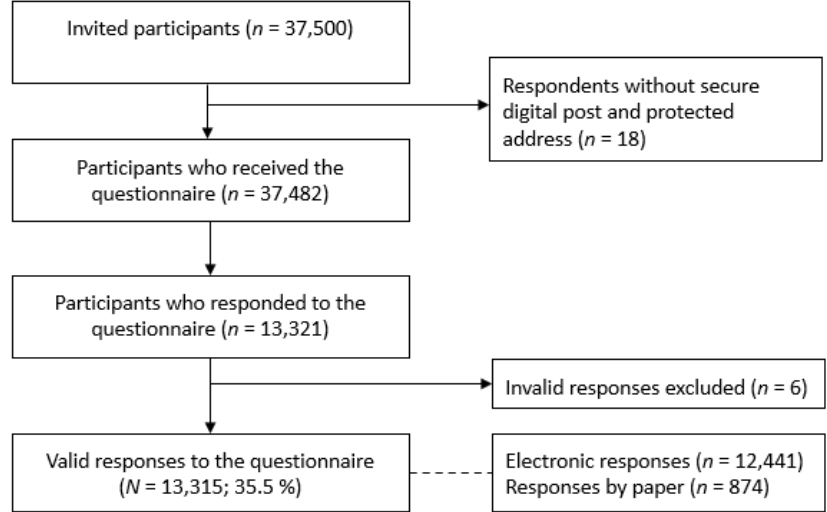
Figure 2. Flowchart of §SMOKE data collection – Baseline 2020.